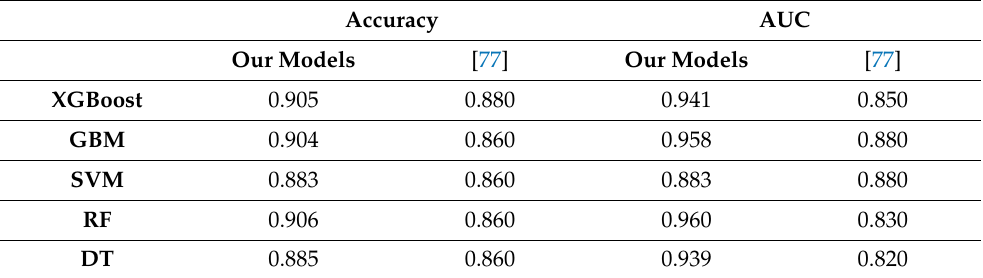
Table 6. Comparison of our ML models with [77] in terms of Accuracy and AUC. Accuracy AUC Our Models [77] Our Models [77]